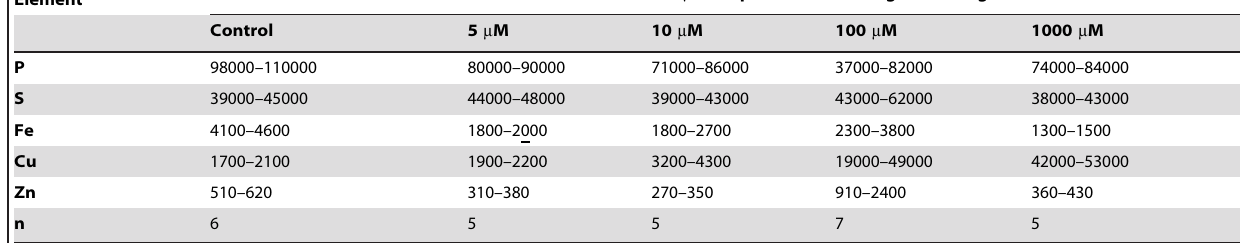
Element 95% confidence intervals on elemental concentrations ( m M) expressed to two significant figures